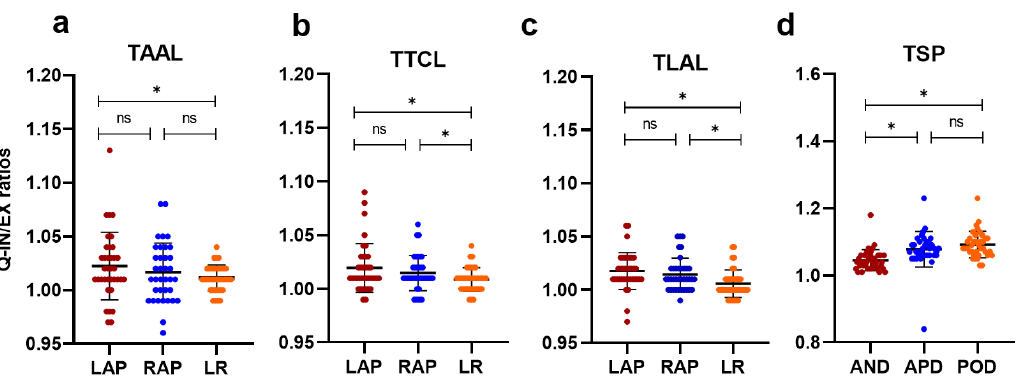
Figure 3. The scatter plots present the difference of ratios between different directions on each plane during quiet breathing ( a – d ). Q-IN/EX ratios, the ratio between end-inspiration and end-expiration in quiet breathing; TAAL, the aortic arch level; TTCL, the tracheal carina level; TLAL, the liver apex level; TSP, The right sagittal plane; LAP, the anterior-posterior distance of left thorax; RAP, the anterior-posterior distance of right thorax; LR, the left to right distance of thorax; AND, the distance between the lung apex and anterior diaphragm on sagittal plane; APD, the distance between the lung apex and diaphragm apex on sagittal plane; POD, the distance between the lung apex and posterior diaphragm on sagittal plane. ns indicated p > 0.05, * indicated p <